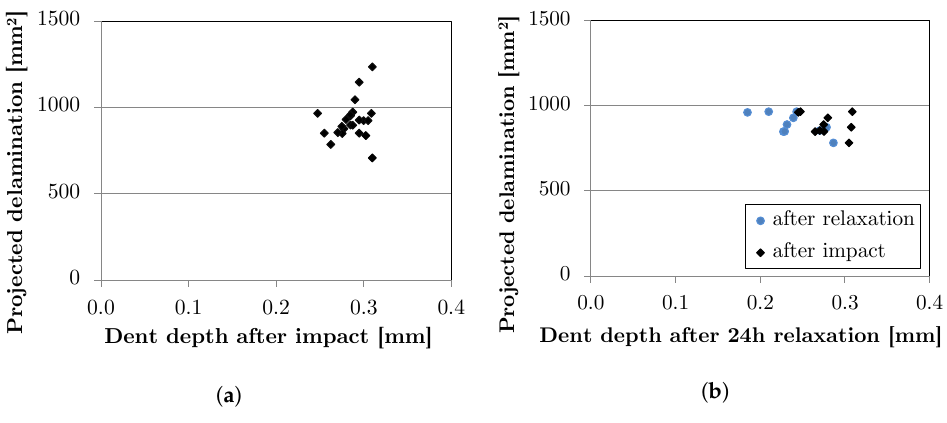
Figure 3. Data points of the measured dent depths and the projected delamination area of the 35J impact experiments Not all specimens were subjected to a dent measurement after relaxation. Hence, not each data point in the diagram Figure 3a corresponds to a data point in the diagram Figure 3b. ( a ) Measurement after the impact, ( b ) Measurement after 24 h relaxation.